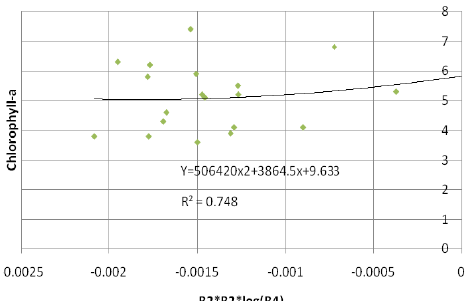
Figure 4. The fitted regression line, its equation and R 2